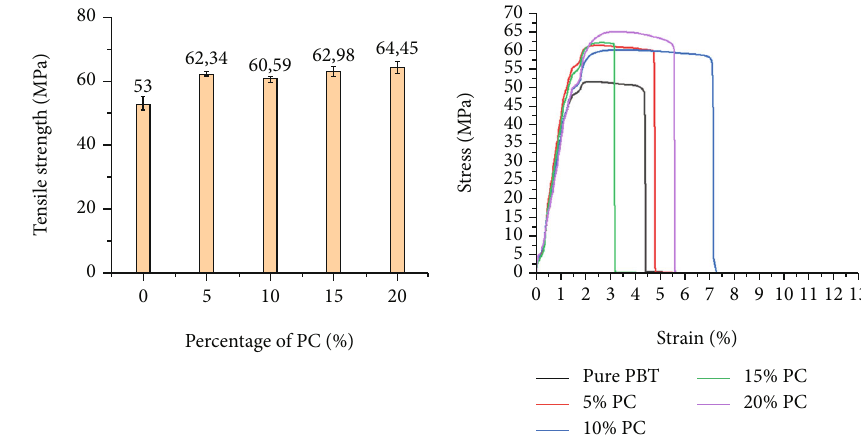
Figure 2: Tensile strength chart and tensile strain-stress diagram. Table 2: Break-strain and elastic of the tensile testing. PBT Sample